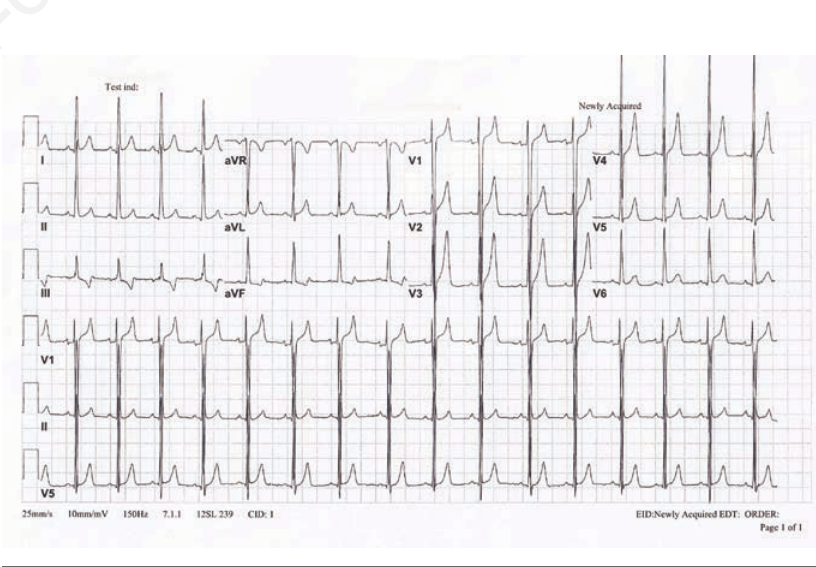
Figure 2. Electrocardiogram at the time of diagnosis showing features of carnitine defi- ciency cardiomyopathy. Note the peaked T-wave along with the short QT